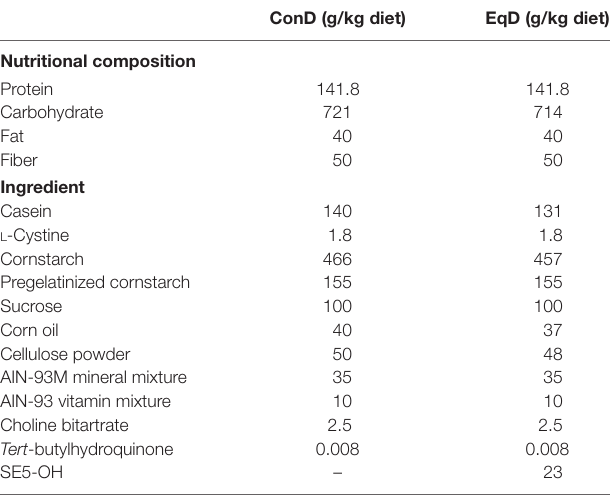
Table 1 | Compositions of the standard (control) diet (ConD) and the S -equol-containing diet (EqD). conD (g/kg diet) eqD (g/kg diet) nutritional